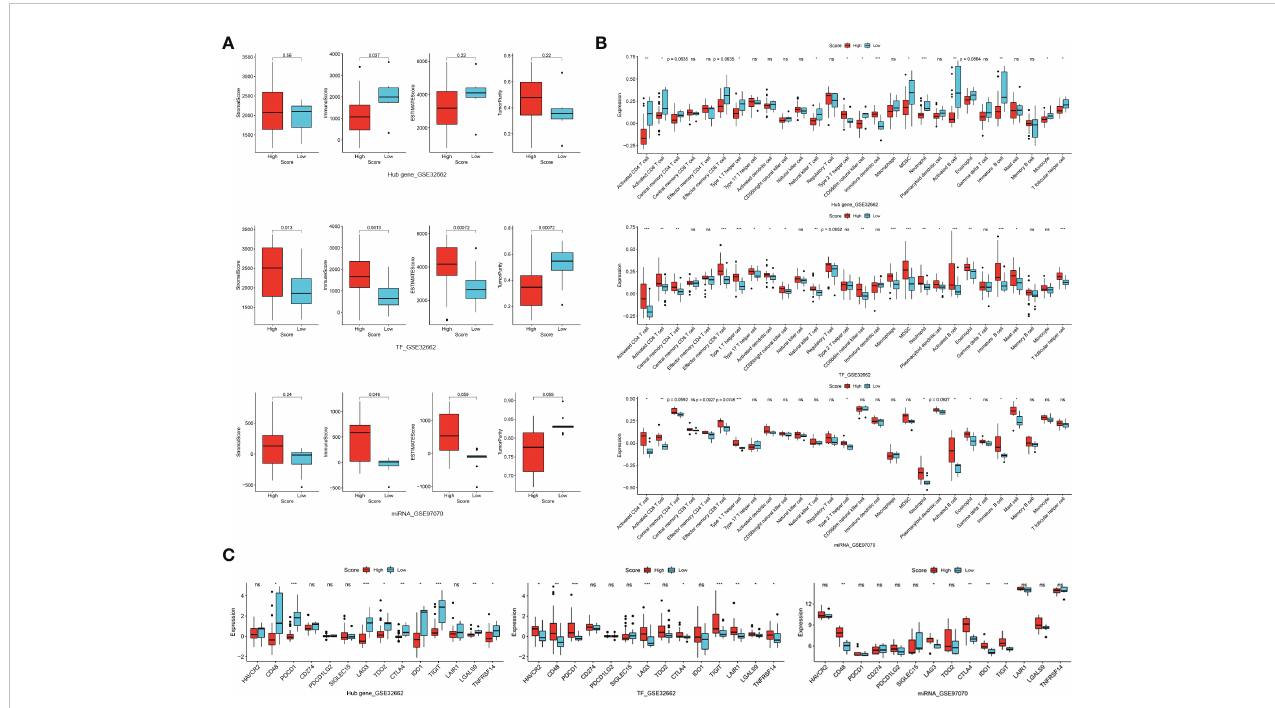
FIGURE 6 Correlation of TF, mRNA and miRNA scores in TF-mRNA-miRNA network with immune characteristics in MTC. (A) The relationships of hub-gene, TF and miRNA scores with stromal score, immune score, ESTIMATE score and tumor purity. (B) The relationships of hub-gene, TF and miRNA scores with immune in fi ltration levels. (C) The relationships of hub-gene, TF and miRNA scores with immune checkpoint genes. Ns, not signi fi cant. *p < 0.05; **p < 0.01; ***p <